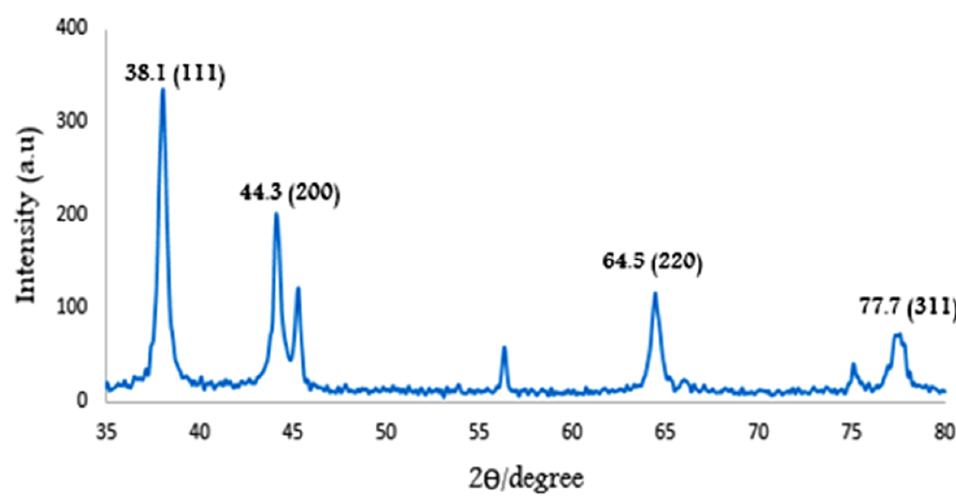
Figure 1. The XRD pattern of the synthesized gold nanoparticles.